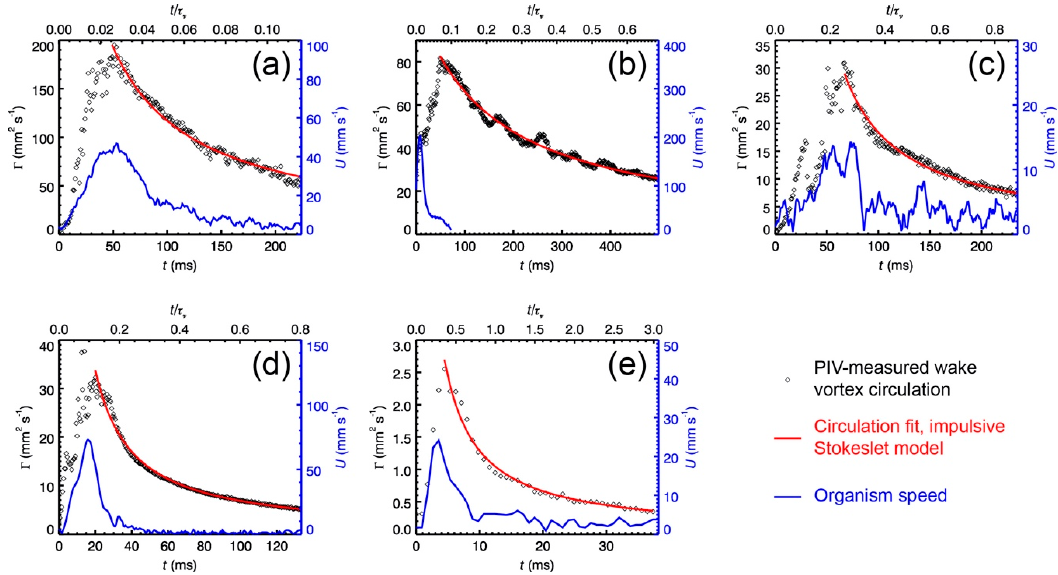
Figure 2. Time evolutions of the time-resolved PIV measured circulations ( Γ ) of the wake vortex ring, fitted decay-phase circulations ( Γ ) to the impulsive Stokeslet model, and body speeds ( U ) for jumps by ( a ) a squid Doryteuthis pealeii paralarva, ( b ) a copepod Calanus finmarchicus , ( c ) a small medusa Sarsia tubulosa (data were obtained by [16]), ( d ) a copepod Acartia hudsonica female, and ( e ) a ciliate Pseudotontonia sp. (data were obtained by [18]). The cases presented here are respectively corresponding to those presented in Figure 1. Time ( t ) is scaled by the viscous timescale τ ν = L 2 /(4 ν ), where L is the body length for ( a – d ); for ( e ), L = (body length + tail length)/2. In the initial acceleration phase that is approximately inviscid, the wake vortex circulation increases from 0 at 0 ms to its maximum value roughly at the time τ (i.e., the thrust duration) through the action of thrust and